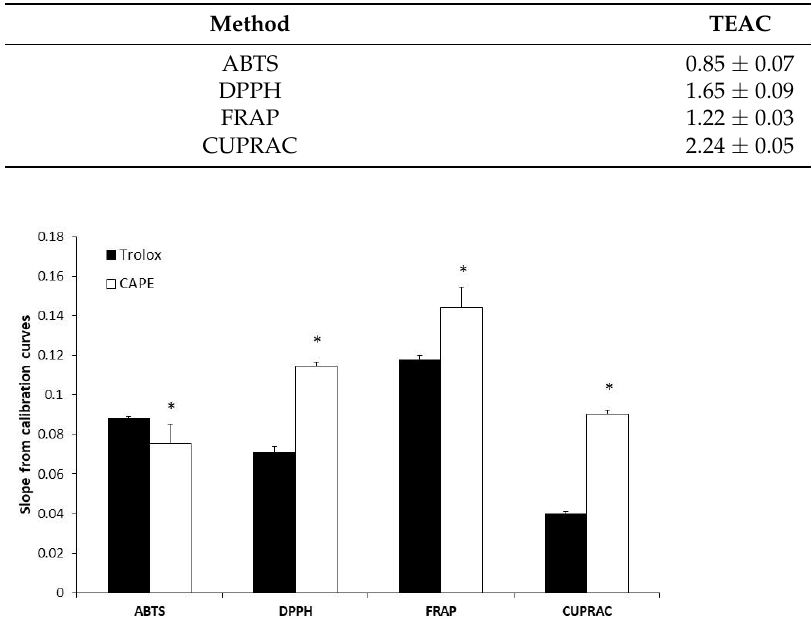
Figure 1. Antioxidant activity of CAPE in vitro. Antioxidant activity was measured, as described in the Materials and Methods section, by ABTS, DPPH, FRAP, and CUPRAC assays. The slope (a) from the calibration curve (y = ax + b) was used to calculate the TEAC value. * p < 0.05 vs. Trolox. Student’s t -test was used to compare the groups.